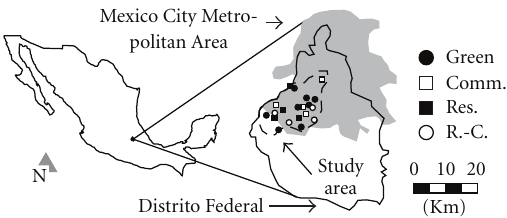
Figure 1: Map of study area. Green: green area, Comm.: commer- cial area, Res.: residential area, R.-C.: residential-commercial area.